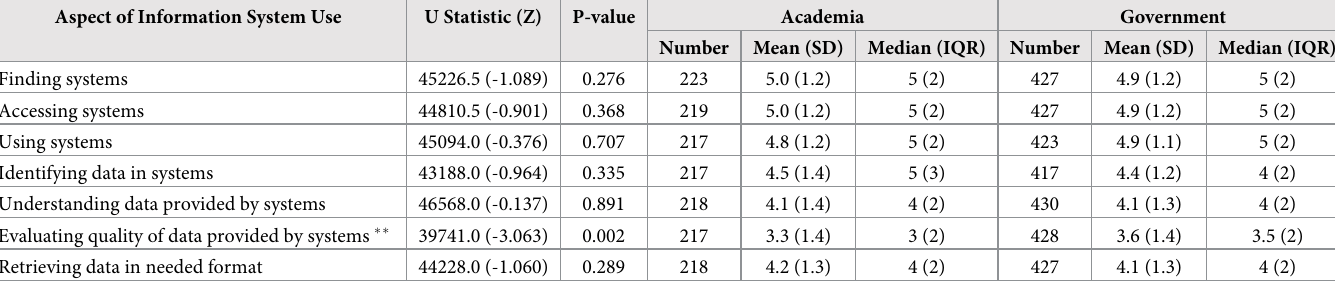
Table 14. Mann-Whitney U tests of ease or difficulty with aspects of information system use.